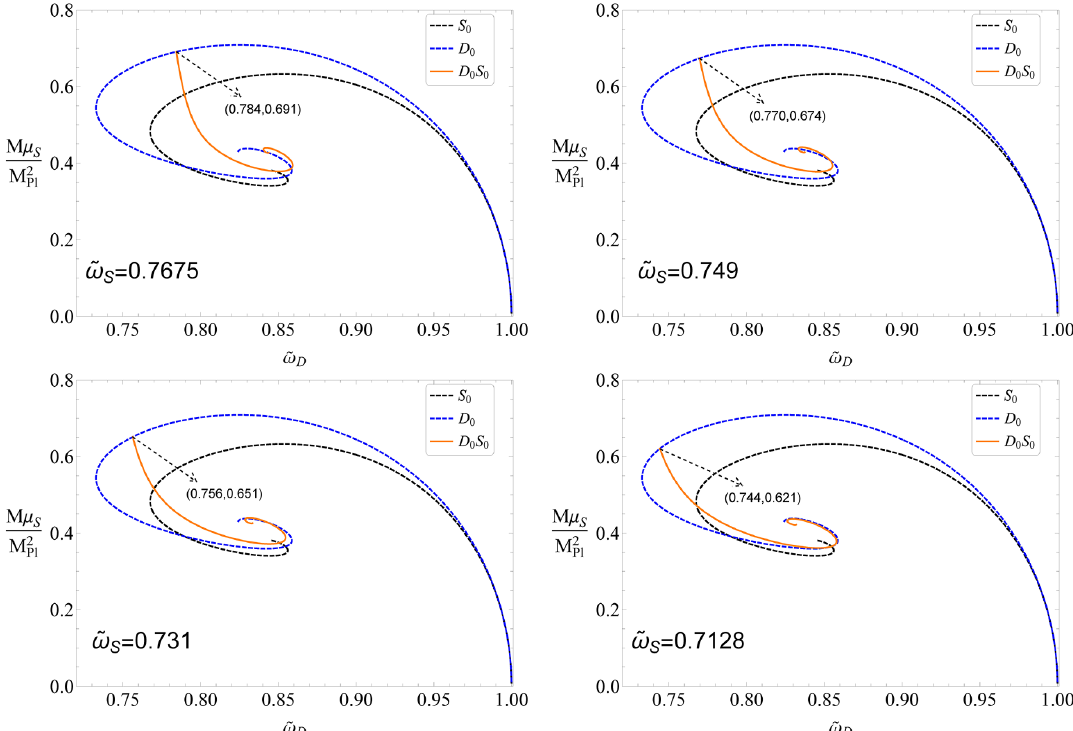
Figure 8. The ADM mass M of the DBSs as a function of the nonsynchronized frequency ˜ ω D for ˜ ω S = 0 . 7675 , 0 . 749 , 0 . 731 , 0 . 7128 . The black dashed line represents the S 0 state solutions, the blue dashed line represents the D 0 state solutions, and the orange line denote the coexisting state D 0 S 0 . All solutions have ˜ µ D = ˜ µ S = 1